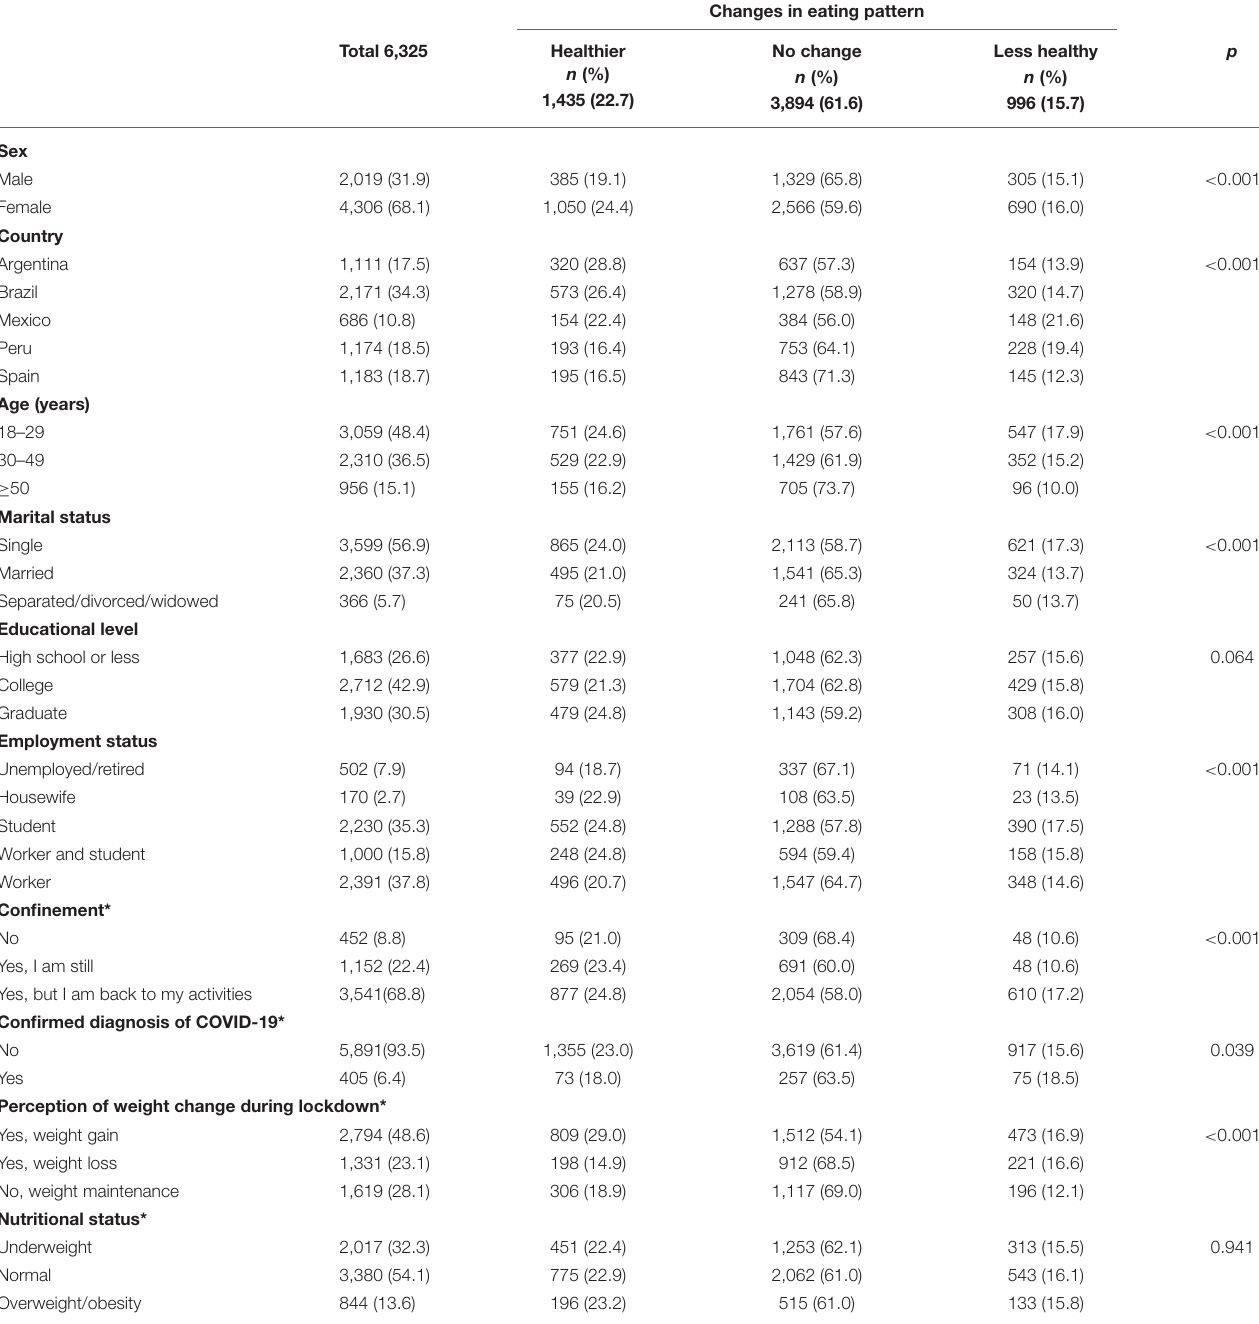
TABLE 1 | Socio-demographic, confinement, diagnosis of COVID 19 and nutritional status characteristics, according to direction of changes in eating patterns during the confinement due to COVID-19